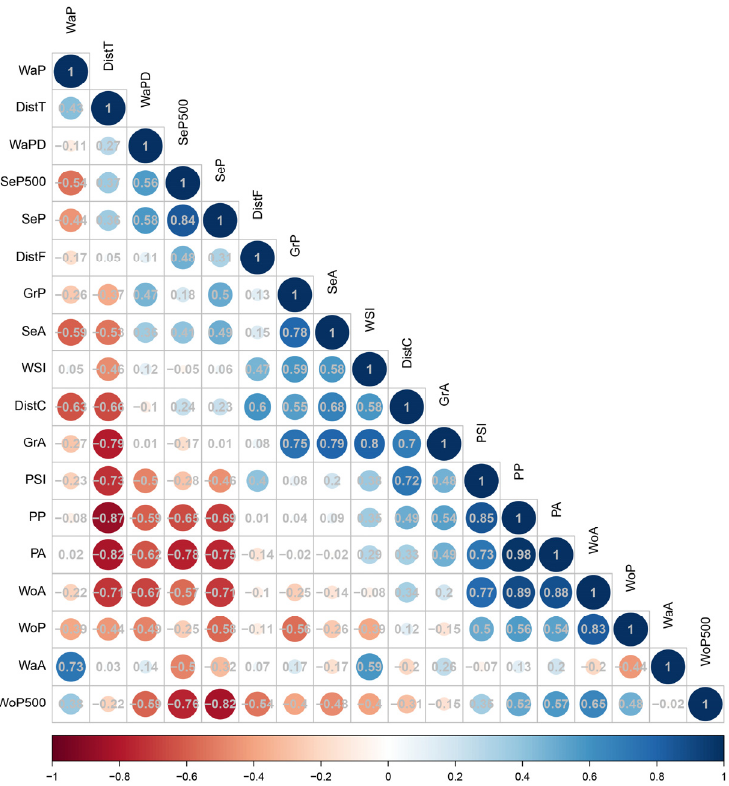
Figure 2. Correlation between 18 predictor variables (landscape features). The value in the circle is the correlation coefficient between the two variables. The blue circles indicate a positive correlation between the two variables, and the red circles indicate a negative correlation between the two variables.